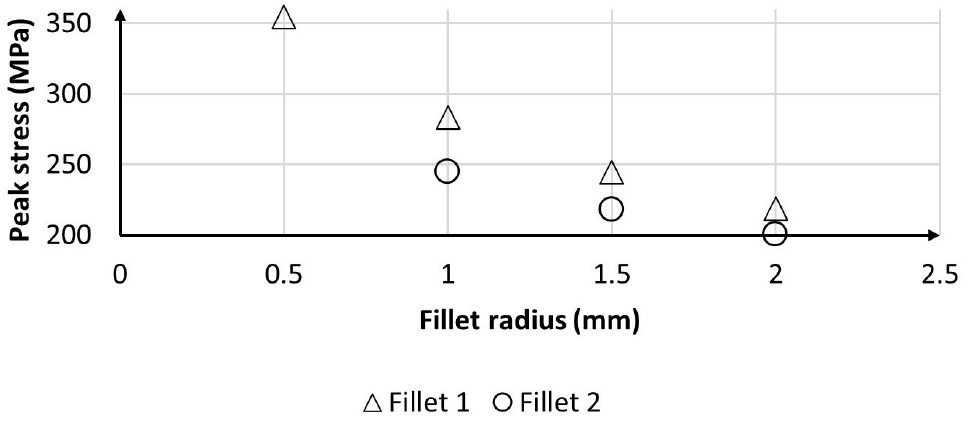
Figure 8. Peak stresses on the fillets designed with different radii (results at p = 6 bar, t = 3 mm and g = 0.1